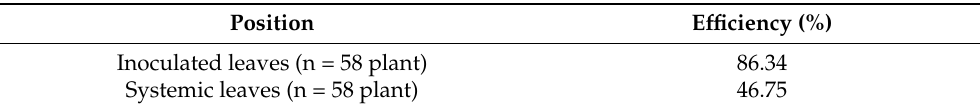
Table 1. Efficiency of the Agrobacterium tumefaciens -mediated infiltration of BrYV into inoculated and systemic leaves.